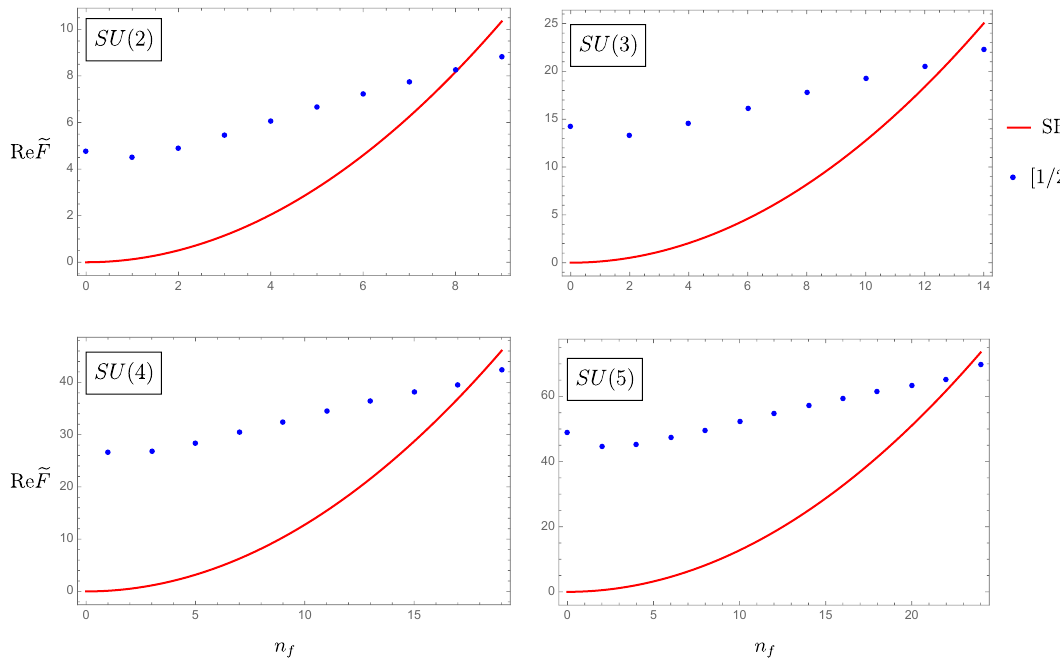
Figure 3 . Comparison between the 3 d value of e F SB (red line) and of the real part of e F conf (blue points) as a function of n